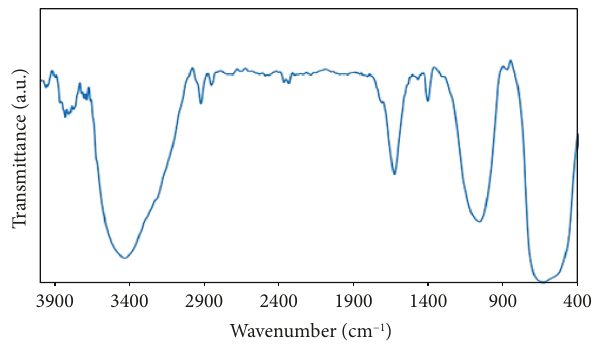
Figure 5: FTIR spectrum of ZNPs.